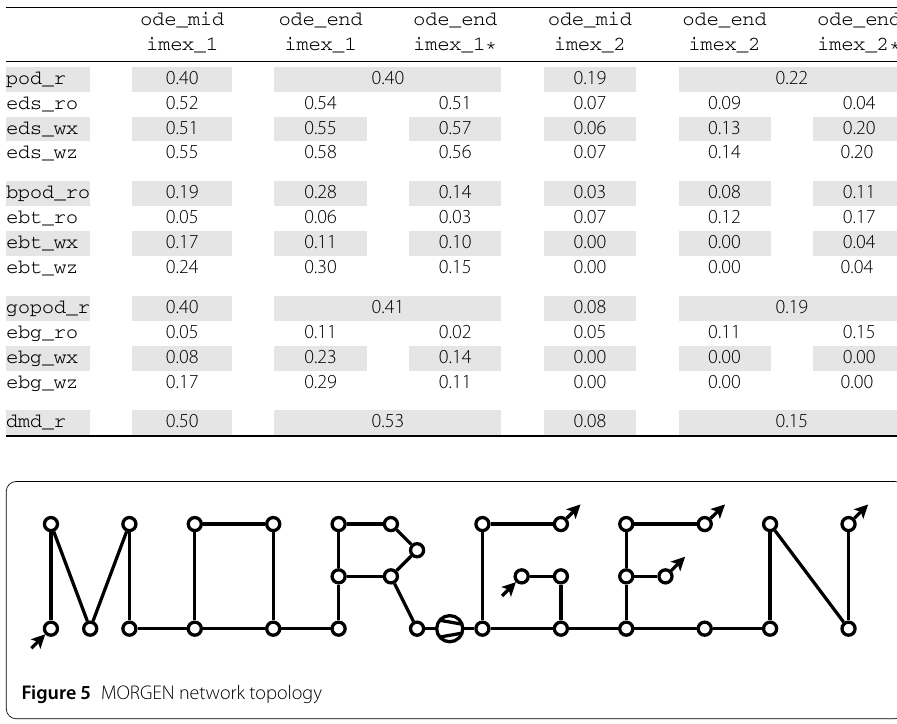
Table 5 MOR SCORE s μ (150, (cid:16) mach(16) ) in the L 2 ⊗ L 2 error norm for the “Yamal-Europe” pipeline network from Sect. 6.2; * notes linear reductors